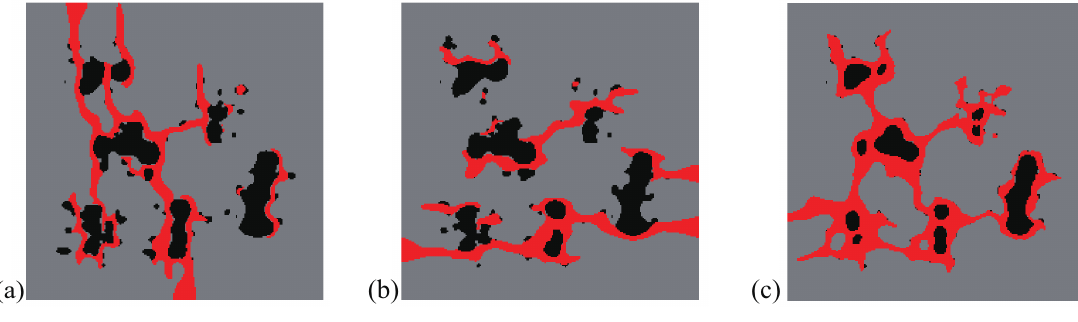
Figure 22. Final crack patterns of: ( a ) final design under load case 1; ( b ) final design under load case 2; ( c ) final design under load case 3.